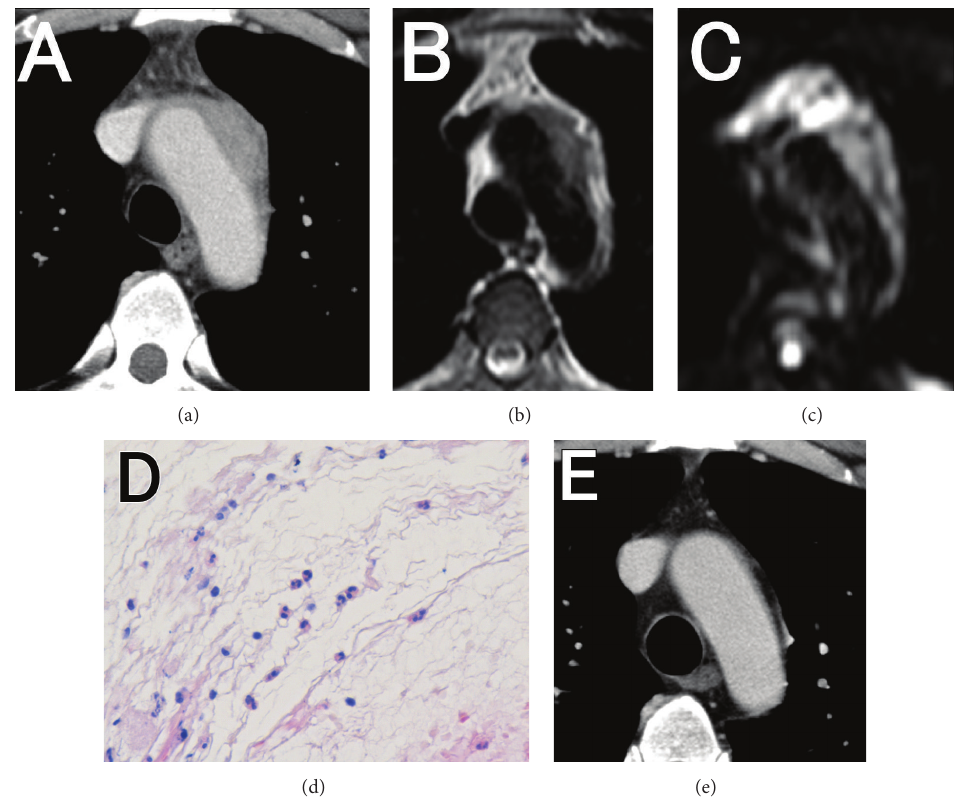
Figure 2: (a) Contrast-enhanced CT imaging showed diffuse thickening of the aortic arch, with enhanced mediastinal connective tissue. ((b), (c)) Gadolinium-enhanced MRI showed low intensity in the T2-weighted sequence (b) and high intensity in the diffusion-weighted sequence (c), suggesting the presence of inflammation. (d) A biopsy of the tissue, using a mediastinal scope, revealed infiltration by inflammatory cells, but no bacteria. (e) A contrast-enhanced CT image 2 weeks after starting the glucocorticoid therapy.